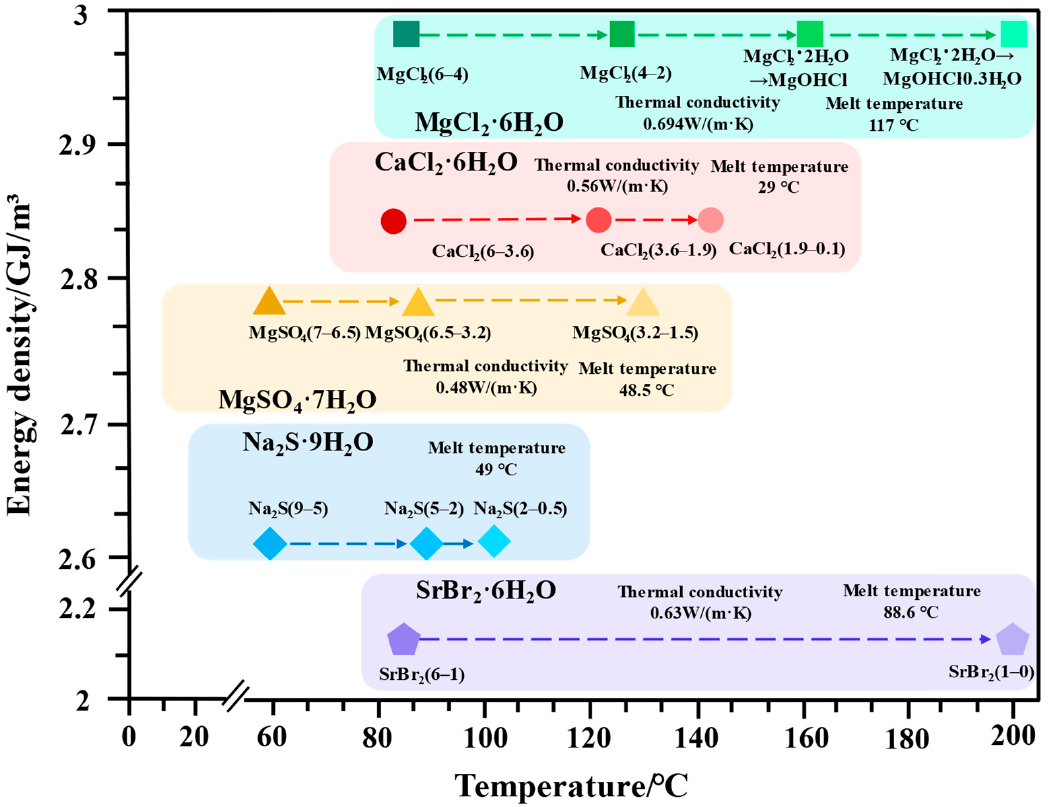
Figure 9. Thermodynamic properties of adsorption-based TCES materials [48–60]: Reprinted with permission from Ref. [48–60]. Copyright © 2021 Elsevier B.V. All rights reserved.